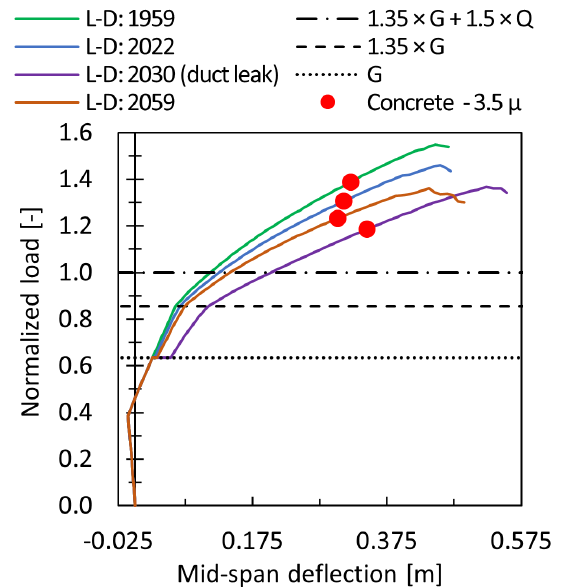
Figure 6. Typical load-deflection (L-D) diagrams for the Wonka bridge with the indication of the load level when the minimum principal strain in concrete exceeds the value of -0.0035.